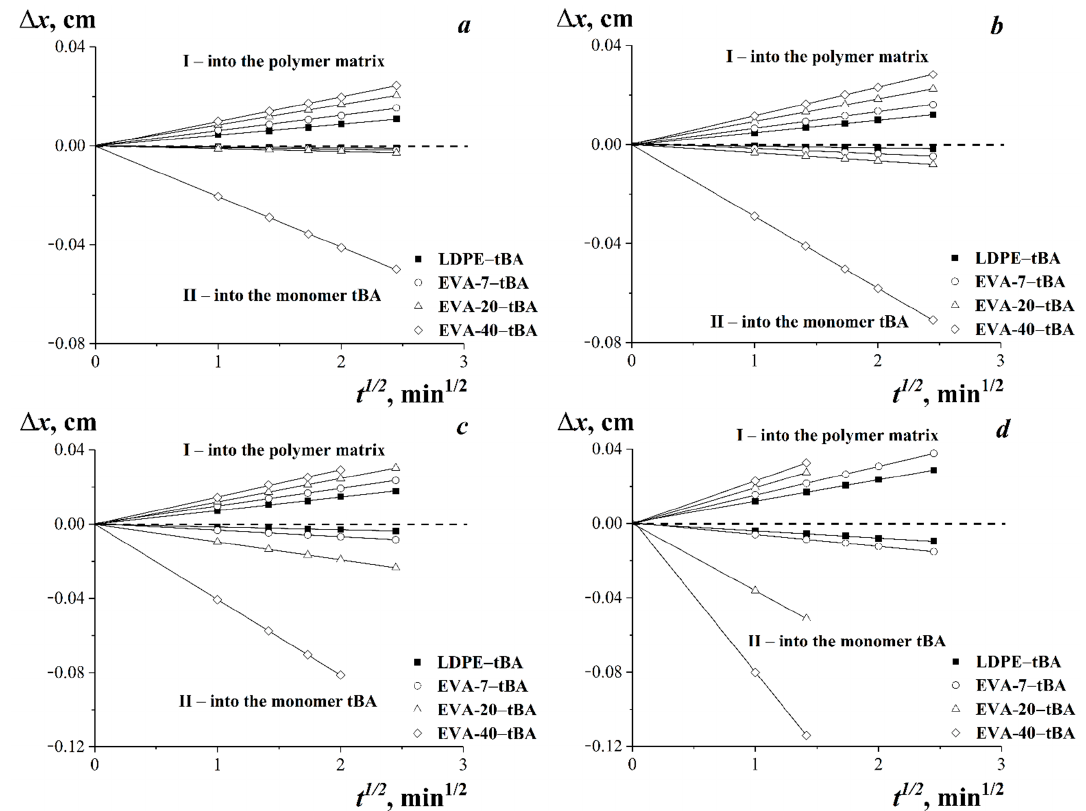
Figure 8. Kinetics of motion of isoconcentration planes of LDPE–tBA, EVA-7–tBA, EVA-20–tBA, and EVA-40–tBA systems. Temperatures: 20 °C ( a ), 40 °C ( b ), 60 °C ( c ), and 75 °C ( d ).